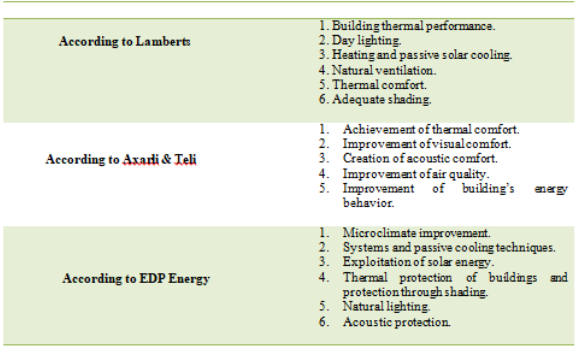
Table 1. Different set of principles as outlined, Lamberts (2006) and Axarli & Teli (2008) EDP Energy